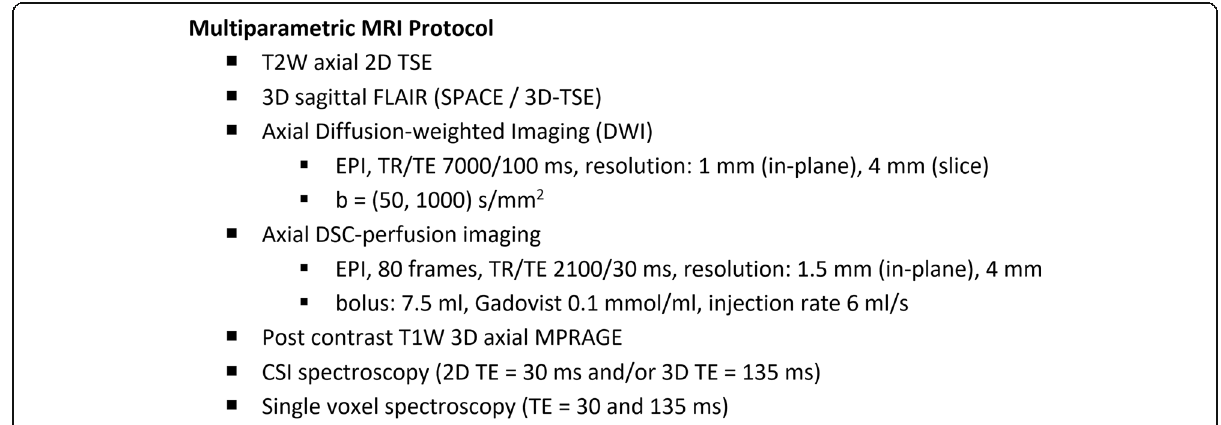
Fig. 1 Multiparametric MRI protocol for intracranial lesions